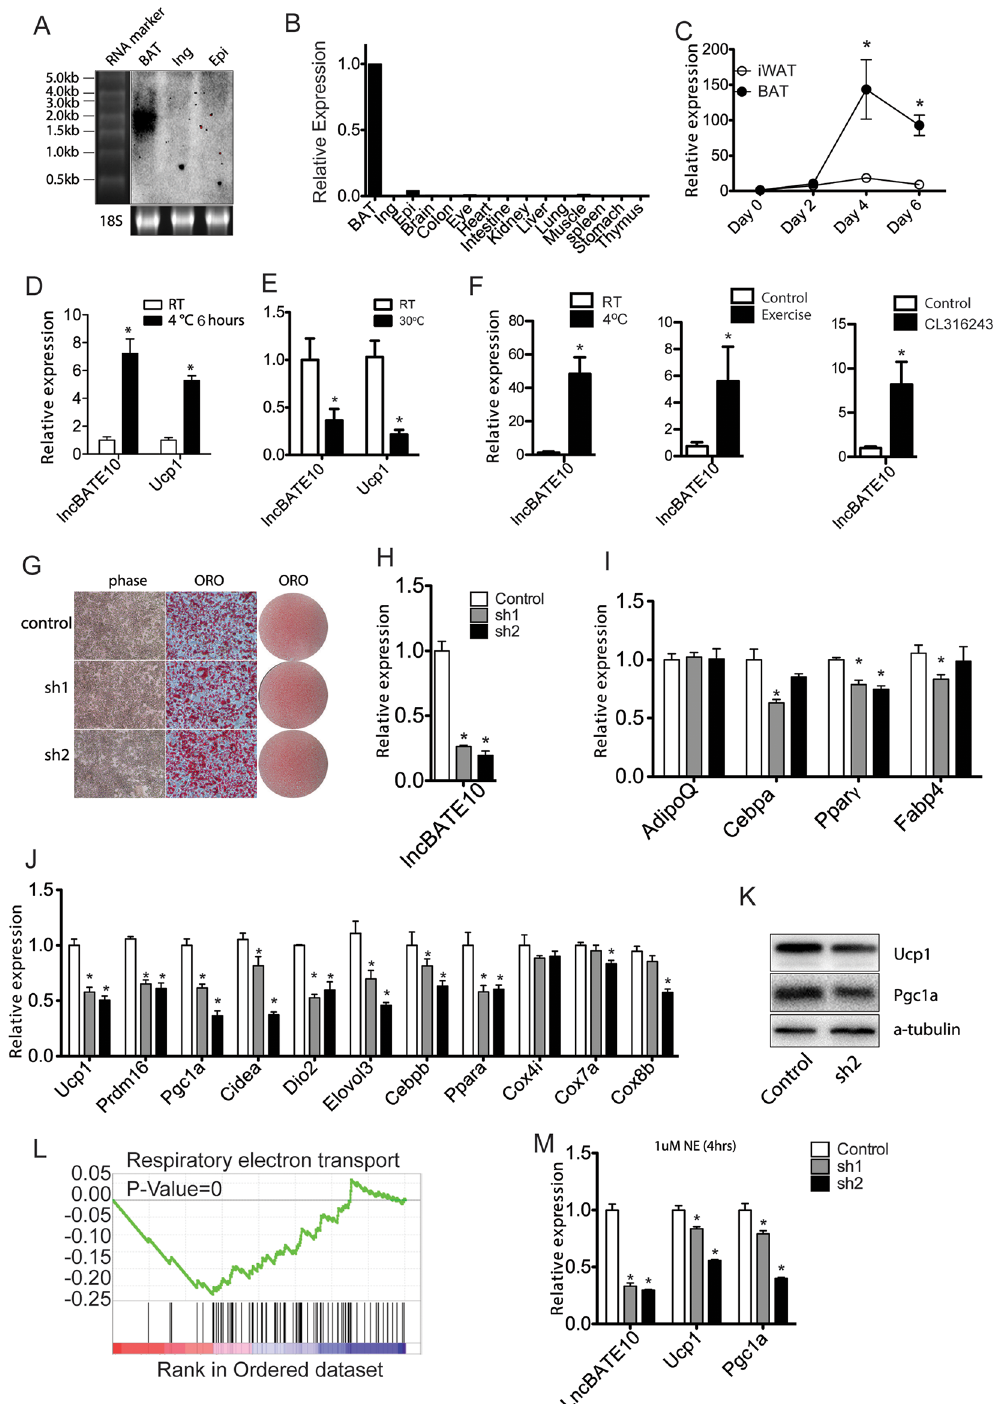
Fig 3. Brown adipose tissue–enriched lncRNA 10 (lncBATE10) is required for a brown adipose tissue (BAT)-selective gene program in brown adipocytes. ( A ) Northernblot to examinethe expressionof lncBATE10 in mouse brown-, inguinal-,and epididymal adiposetissues. ( B ) Real-timePCR result of lncBATE10 across mouse tissues and ( C ) differentiationtime course of primary brown and white adipocyteculture. Error bars represent mean ± SEM, n = 3. * P < 0.05. ( D ) Expression of lncBATE10 in BAT isolated from animalstreated with acute cold exposure(4˚C for 6 hours). Error bars represent mean ± SEM, n = 4. * P < 0.05. ( E ) Hosted at